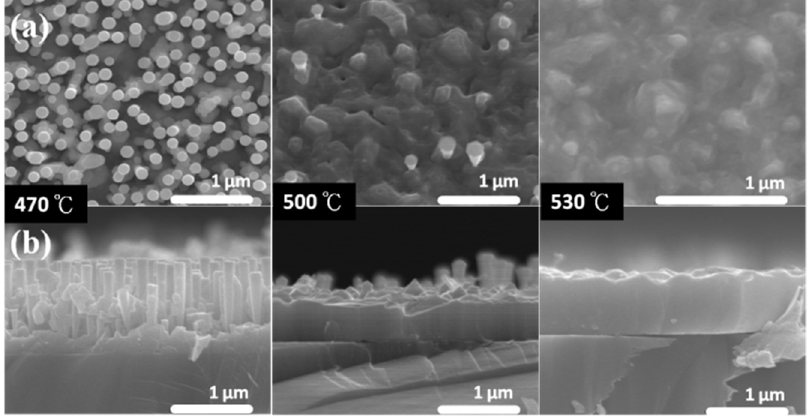
Figure 1. Scanning electron microscopy images of InN samples: ( a ) top-view images and ( b ) cross- sectional images.